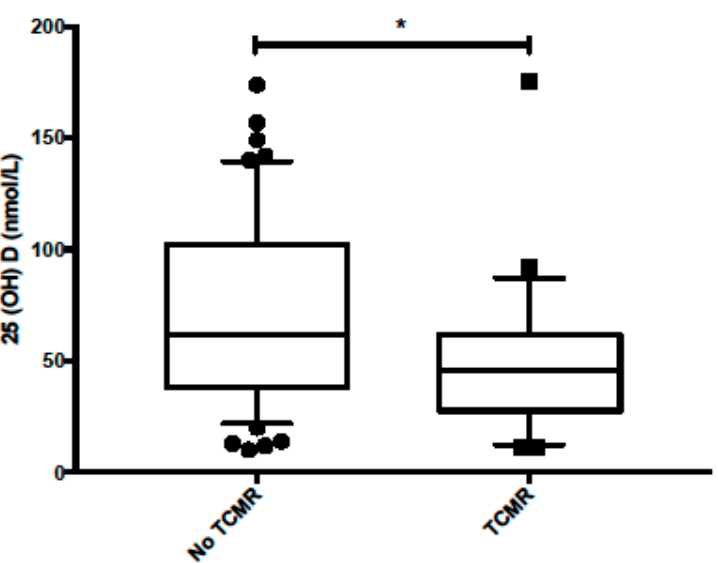
Figure 3. Comparative plot of 25(OH) levels between no-TCMR and TCMR group. * p = 0.03.